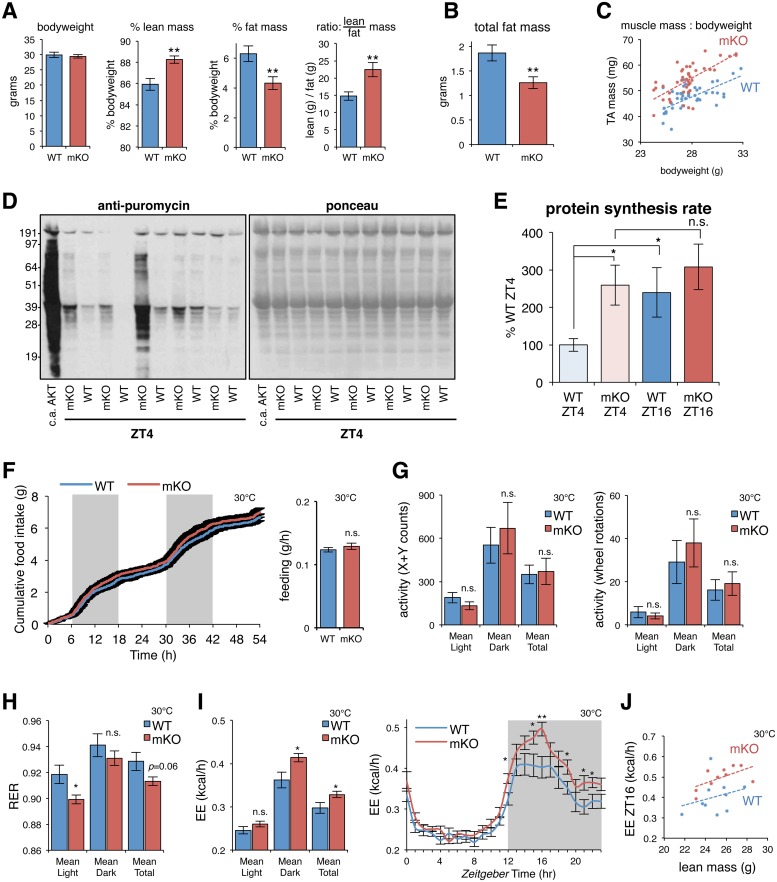
Muscle-specific loss of BMAL1 associated with fat-to-lean mass partitioning, increased rates of muscle protein synthesis, and increased EE.(A-B) n = 11–12 mice; 5-mo-old male littermates; mean ± SEM; **p < 0.01, Student’s t test. (A) Normal bodyweight, increased percent lean mass, reduced percent fat mass, and increased lean-to-fat mass ratio in mKO mice. (B) About 30% reduced total body fat. (C) Increased muscle mass relative to bodyweight (TA; n = 44 five-mo-old male littermates; dashed line indicates mean trend line). (D-E) In vivo protein synthesis rates of TA measured by IV-SUnSET. (D) Representative image of western blot analysis for puromycin-labeled peptides followed by ponceau staining to verify equal protein loading. TA from a transgenic mouse with c.a.AKT was used as positive control. (E) Quantification of puromycin-labeled peptides expressed as a percentage of the values obtained in WT ZT4 (mean ± SEM; n = 10, ZT4; n = 5, ZT16; *p < 0.05, Student’s t test). (F-I) Effects of muscle-specific Bmal1 mKO on (F) food intake, (G) locomotor activity (X + Y axis counts and running wheel rotations), (H) RER (VCO2/VO2), and (I) EE all measured at thermoneutrality (30 °C). n = 10 four-mo-old male littermates; mean ± SEM; *p < 0.05, Student’s t test; ANCOVA genotype effect p = 0.046 (total EE) and p = 0.023 (dark phase EE) when considering body weight, lean mass, and fat mass as covariates. (J) Relationship between EE and lean mass at ZT16 (n = 10; dashed line indicates mean trend line). Underlying data can be found in supporting file S1 Data. BMAL1, brain and muscle ARNT-like protein 1; c.a.AKT, constitutively active AKT; EE, energy expenditure; IV-SUnSET, in vivo surface sensing of translation; mKO, myocyte-specific loss of BMAL1; n.s., not significant; RER, respiratory exchange ratio; TA, tibialis anterior; VCO2, volume carbon dioxide produced; VO2, volume oxygen consumed; WT, wild type; ZT, Zeitgeber time.